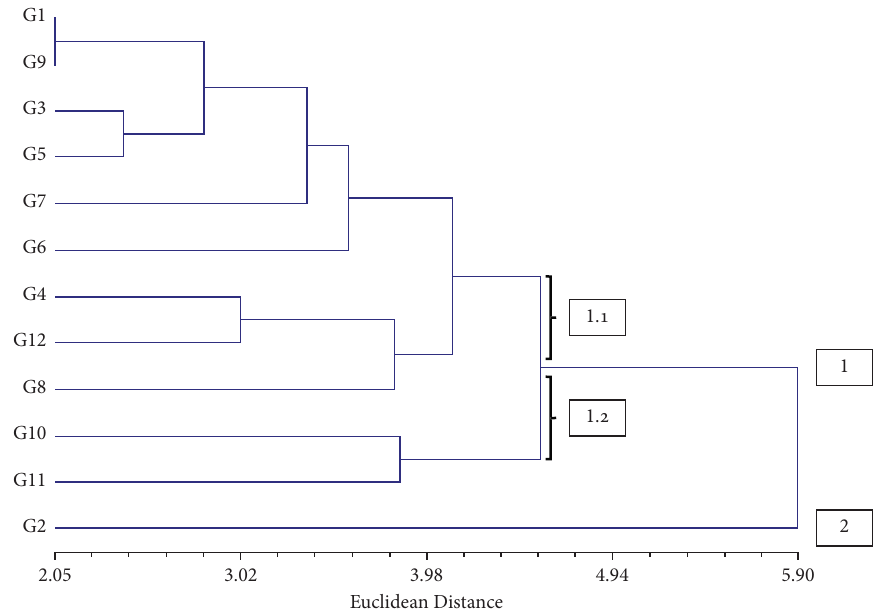
Figure 8: Dendrogram for nine genotypes of PFSP and three commercial varieties as checks based on agronomic traits in